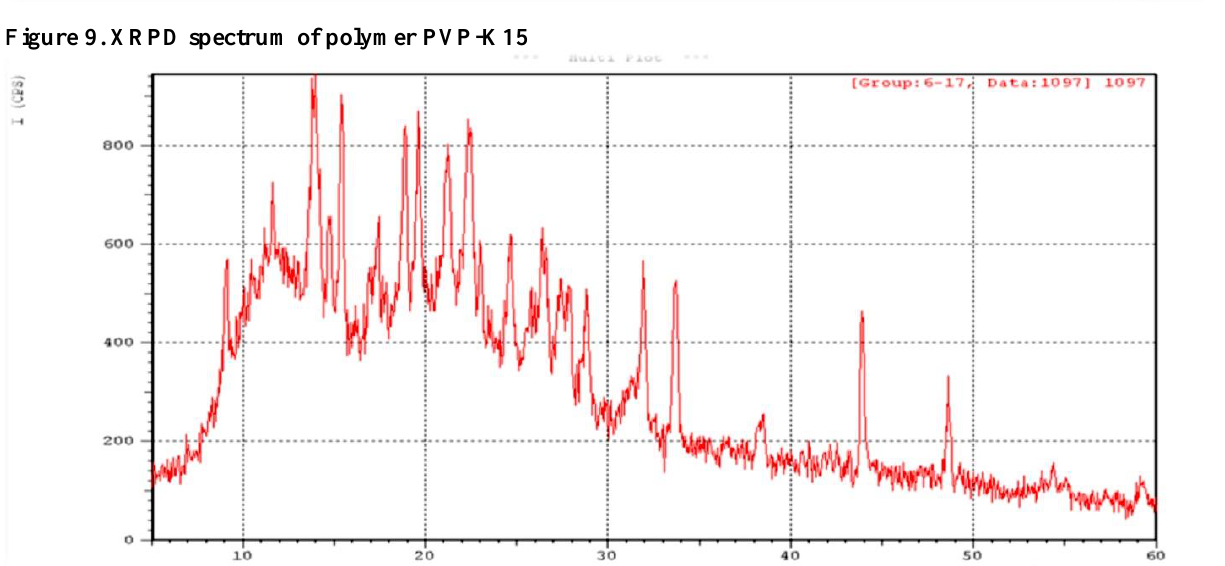
Figure 10. XRPD spectrum of physical mixture of PVP-K15 and pure domperidone (at ratio of